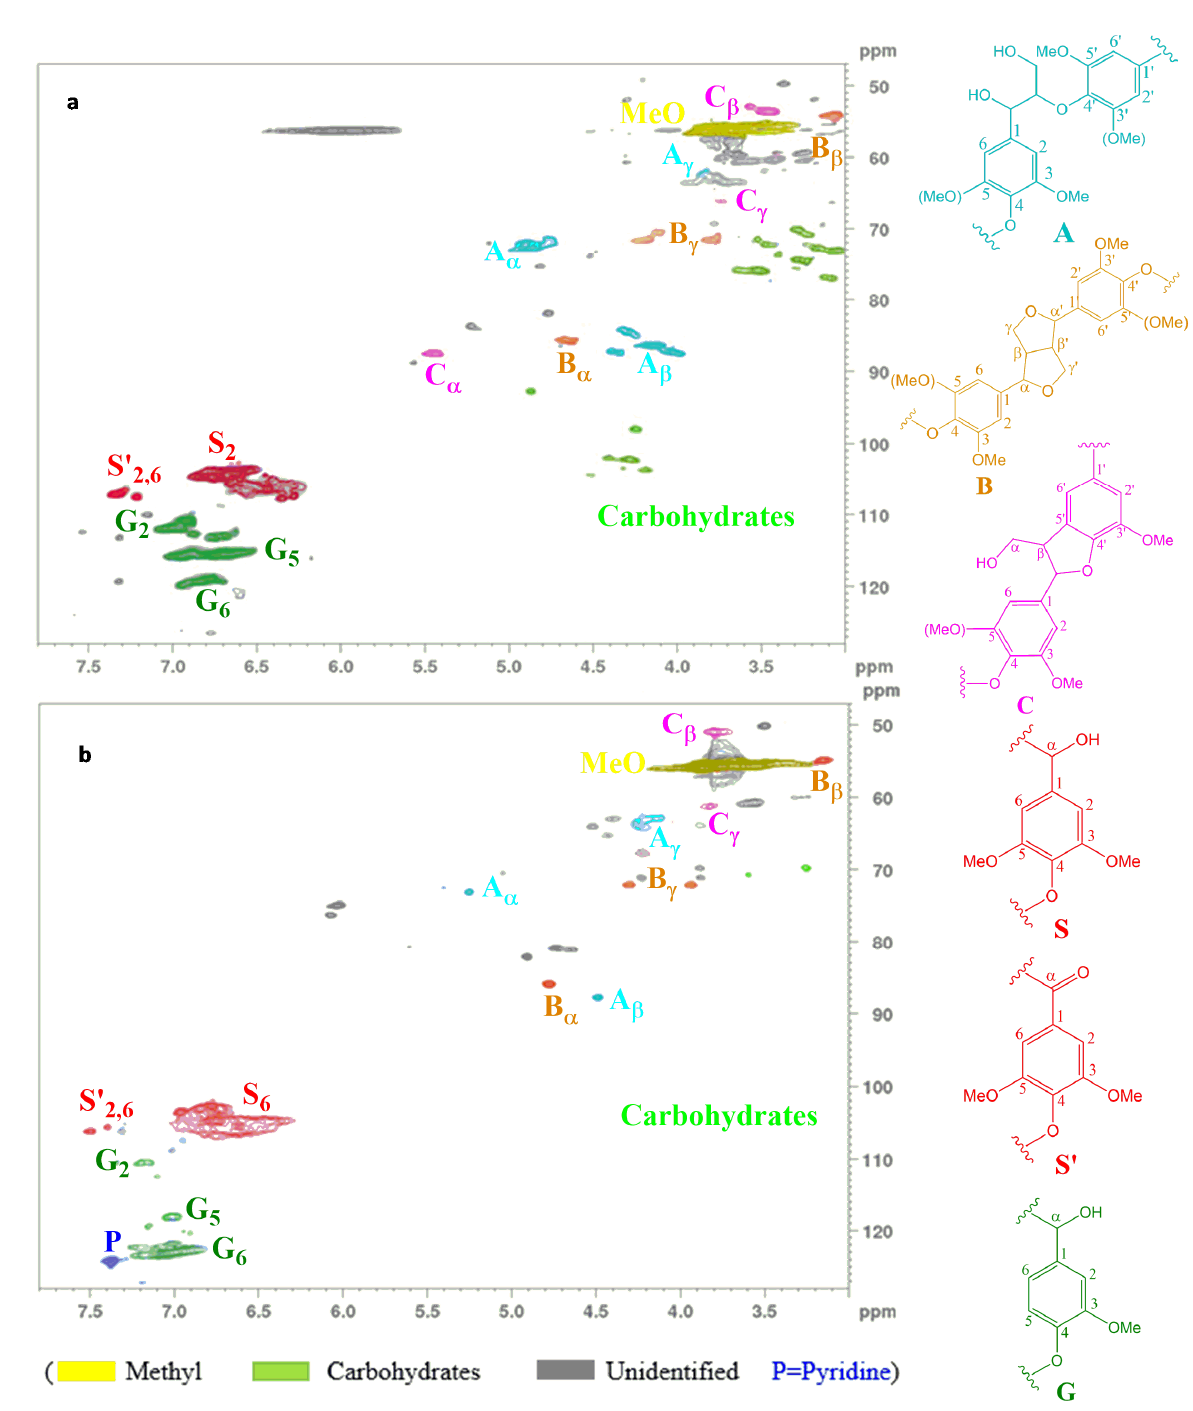
Figure 1. 2D HSQC spectra of lignin fractions: ( a ) before (L); and ( b ) after acid hydrolysis of hot-water extract. (LAH). Assignments in accordance with